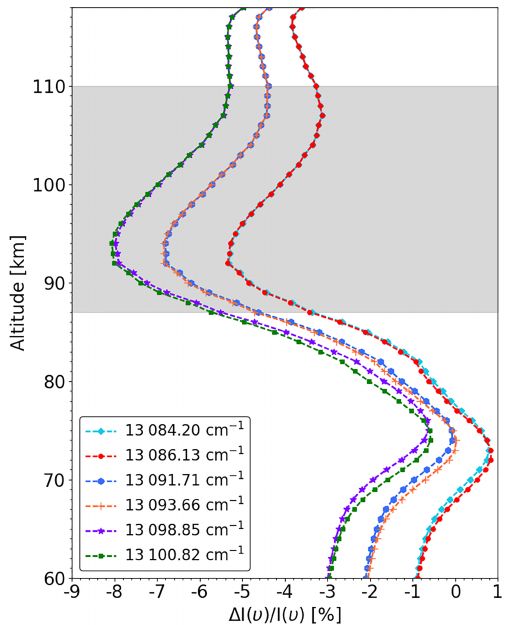
Figure 4. Response of irradiance ( (cid:49)I(υ)/I(υ) ) to temperature ( (cid:49)T = 10K) at different tangent altitudes for individual emission lines. The tangent altitudes covered by the grey shaded area (87– 110km) has a higher sensitivity of the irradiance to temperature